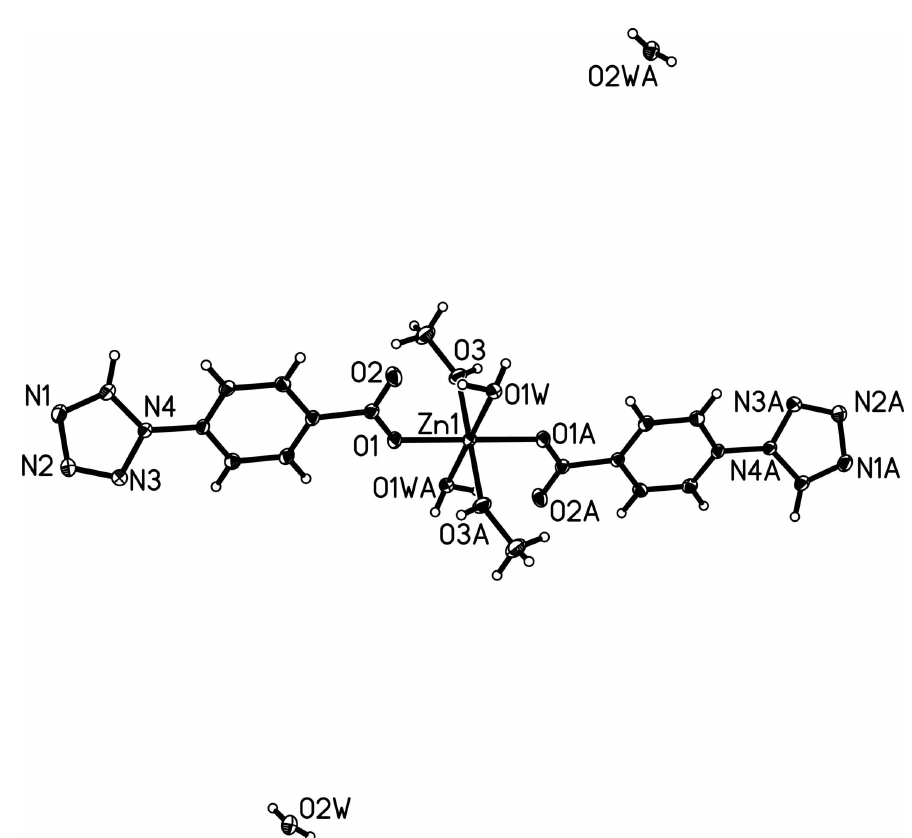
Figure 1 The molecular structure of (I), with 30% probability displacement ellipsoids. [Symmetry code: (A) -x+1, -y, -z+2.]